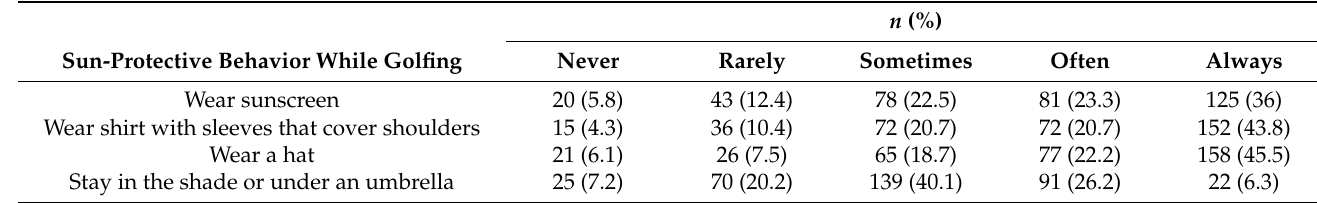
Table 2. Golfers’ use of sun-protective